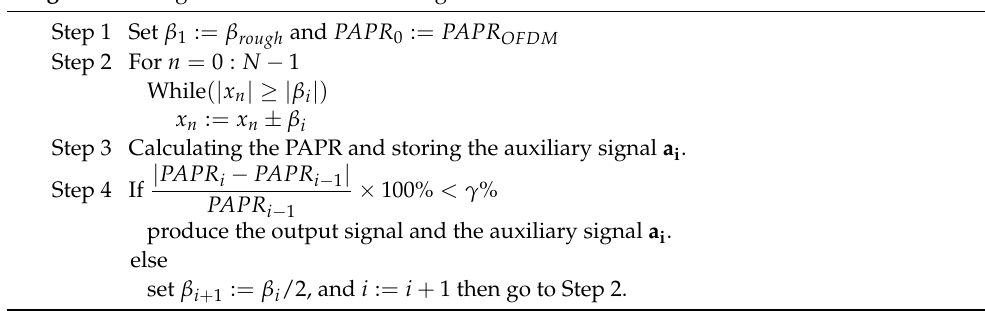
Algorithm 2 Algorithm for the second stage